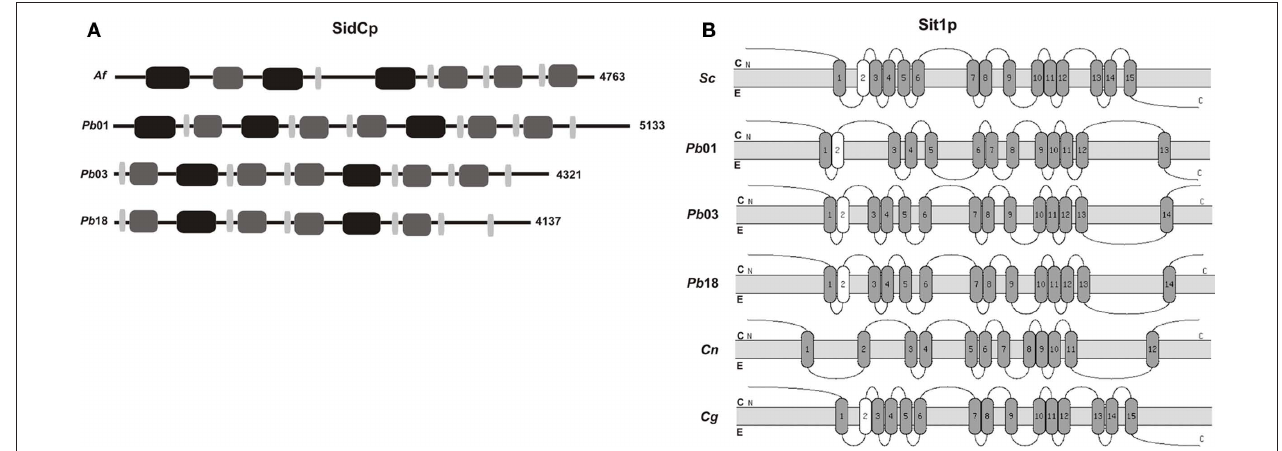
FiGure 3 | Conserved features in proteins involved in biosynthesis and uptake of siderophores. (A) Modular organization of SidCp in P. brasiliensis isolates. Black boxes represent adenylation (A) domain, dark gray boxes illustrate the condensation (C) domain and light gray boxes represent the peptidyl carrier (PCP) domain. The length of each protein, in amino acids, is shown on the right. (B) Topology of transmembrane domains of Sit1p from S. cerevisiae , P. brasiliensis isolates and Cryptococcus species. White boxes represent